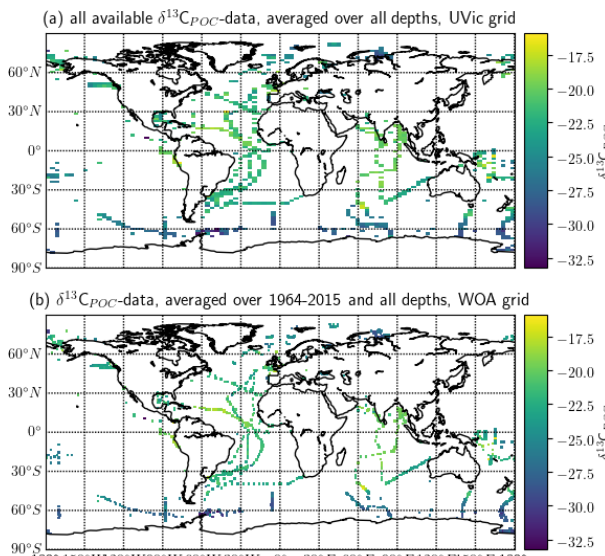
Figure 6. Global distribution of the δ 13 C POC data is visualized based on the (a) UVic grid and (b) WOA grid. The data used for (a) are independent of time and include all available measurements with latitude and longitude information. The data shown in (b) in- clude only data with complete temporal metadata and are averaged over the years 1964–2015. Both kinds of data are averaged over all measurements including data with missing depth information. Each colored square refers to a grid cell with available δ 13 C POC mea- surements. The colors indicate the δ 13 C POC value in the respective grid cell. Table 4. Data coverage within the available decades: the first col- umn lists the available decades and the second column the number of sampled δ 13 C POC data points within this time